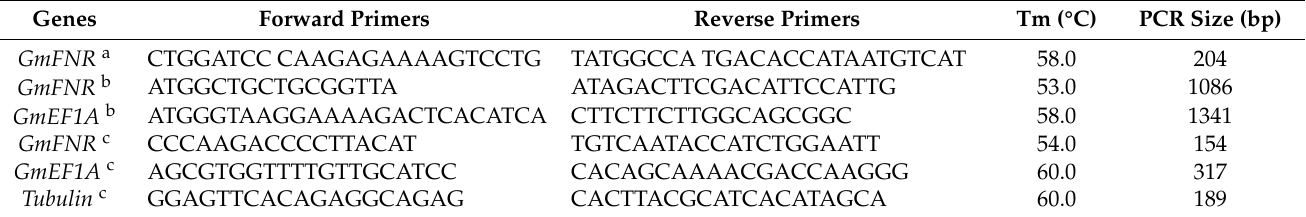
Table 1. Primer sequences used in this